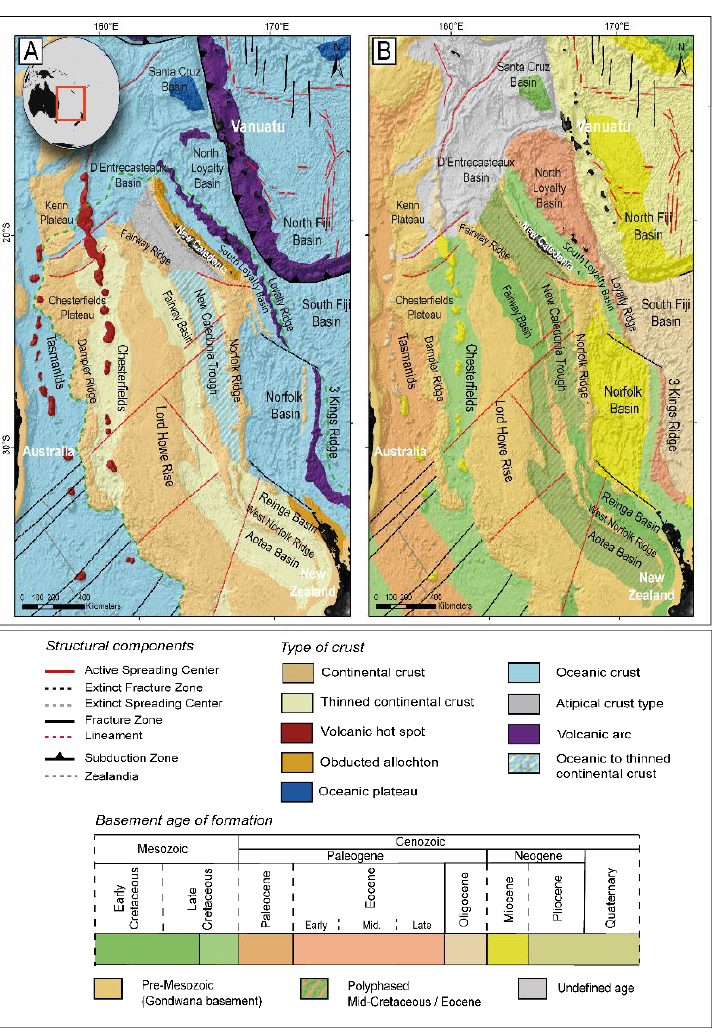
Figure 1. ( A ) Nature of basement of the South-West Pacific (modified after [33]); ( B ) Age of basement formation of the South-West Pacific (modified after [33]).